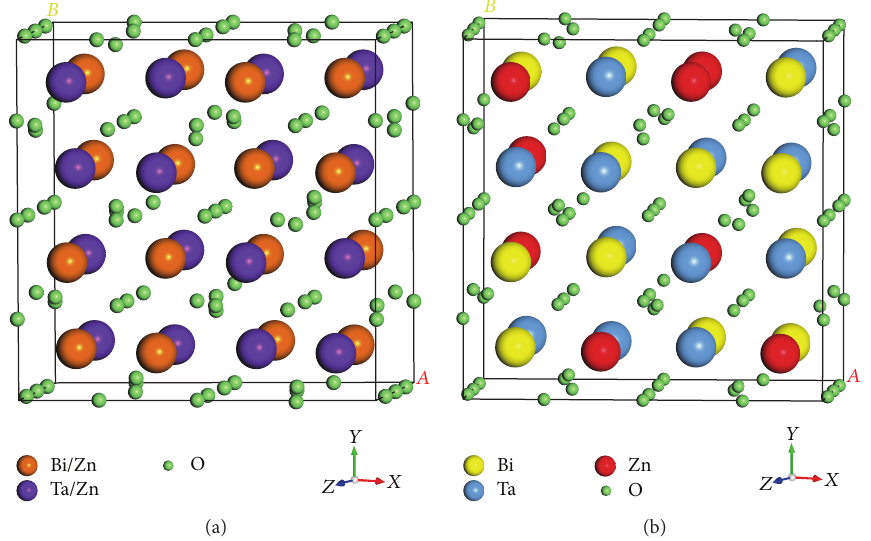
Figure 1: BZT structures assuming (a) random and (b) ordered solid solutions (pure Bi, Ta, Zn, and O are yellow, blue, red, and green balls, while Bi/Zn and Ta/Zn mixed cations are orange and purple balls, resp.).